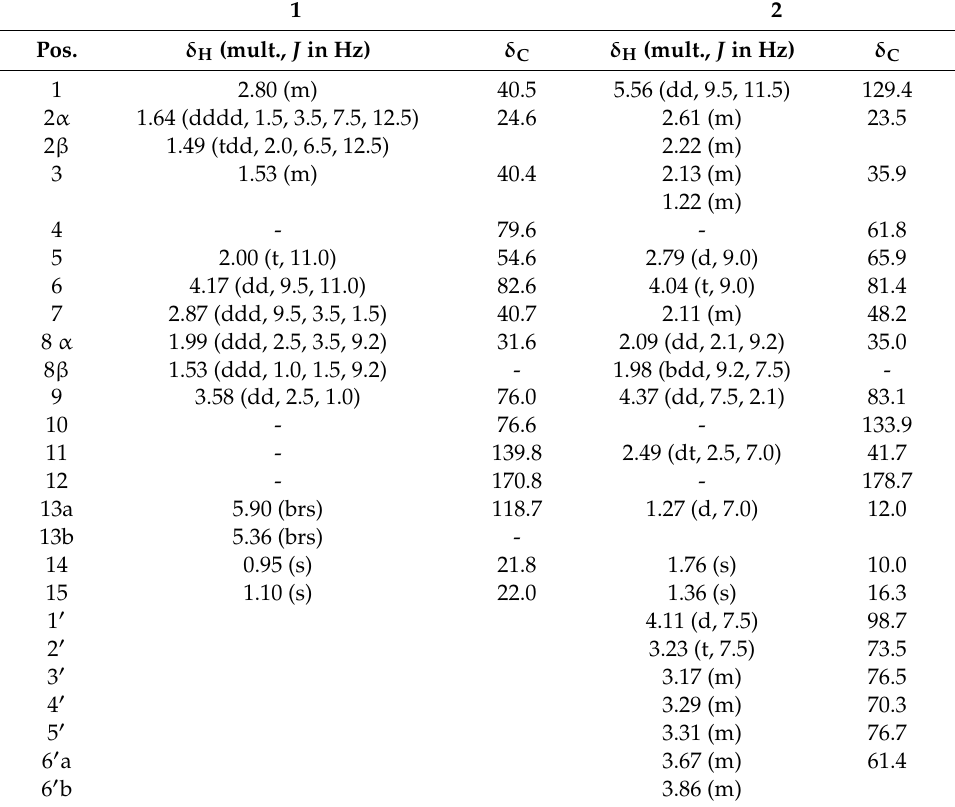
Table 1. 1 H (500 MHz) and 13 C (125 MHz) NMR data for compounds 1 and 2 in CD 3